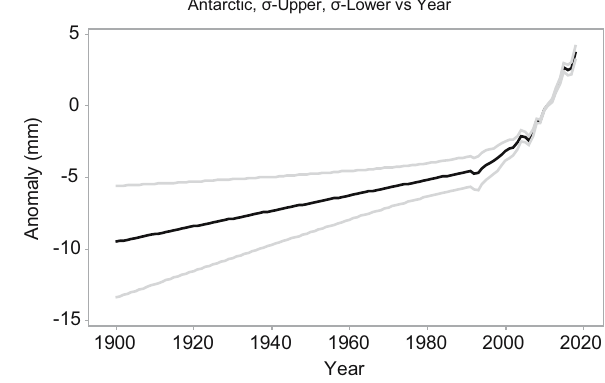
Figure 2: Yearly averaged anomalies of Glaciers component and their a priori uncertainties ( SE ) during 1900 – 2018 ( Frederikse et al. 2020 ) .